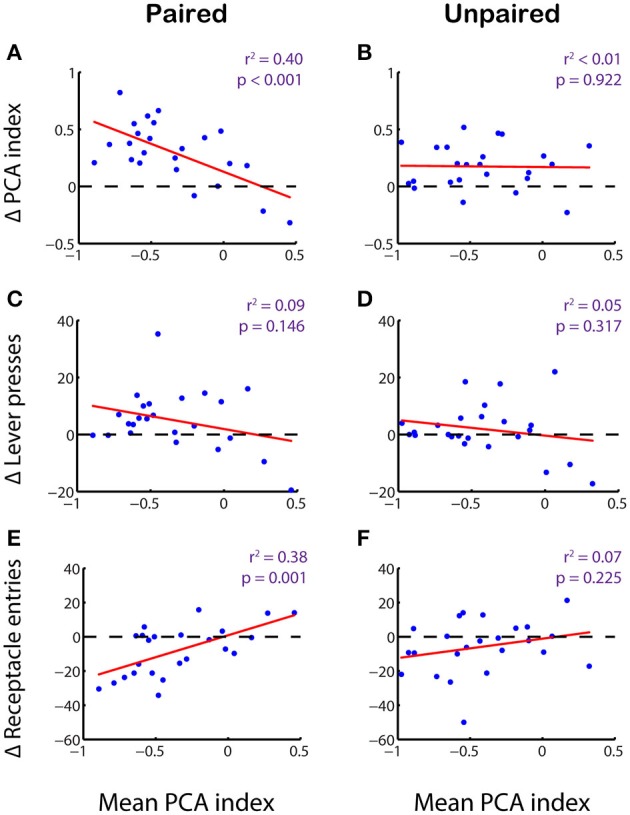
The effectiveness of reward devaluation varies with individual subjects' propensity to goal-track. PCA index of individual subjects during training (average over last 4 sessions) plotted against change in PCA index (A,B), total lever presses during CS-on periods (C,D), or total receptacle entries during CS-on periods (E,F) between training and test session for the paired (A,C,E) and unpaired (B,D,F) groups. Regression lines in red.